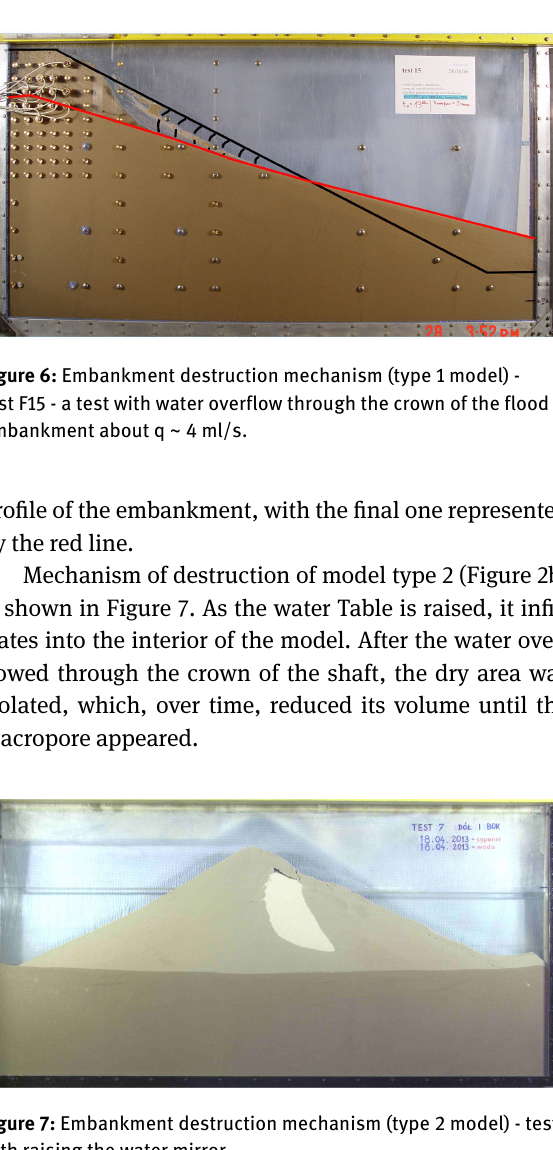
Figure 7: Embankment destruction mechanism (type 2 model) - test with raising the water mirror.